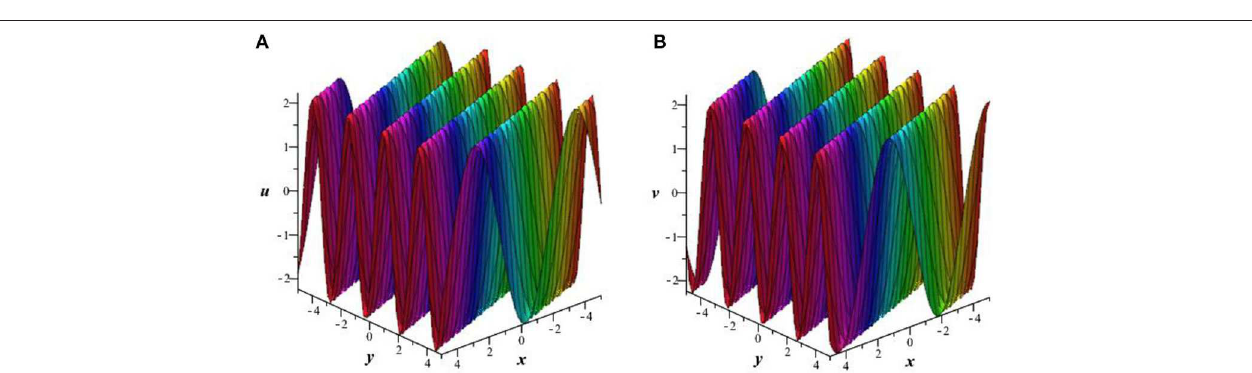
FIGURE 2 | Plot of invariant solution (36) with δ 1 ( t ) Perspective view of the solution v .